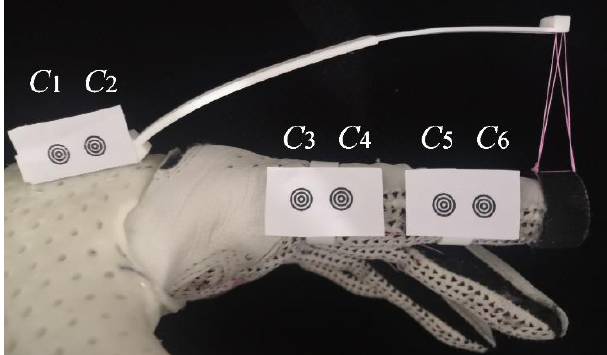
Figure 10. Experiment setup for recording the index finger motion with six rippled markers.